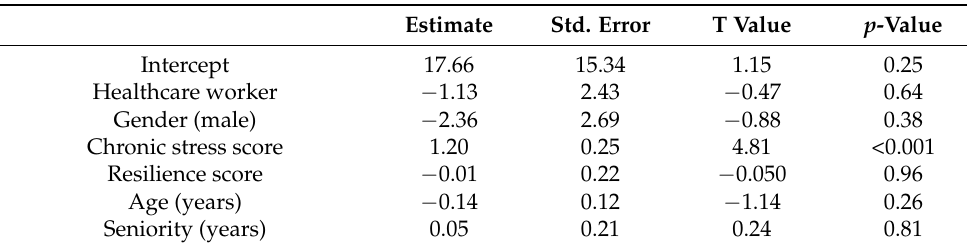
Table 3. Results of the multiple linear regression analysis of Q1 results. The dependent variable was the Q2 work-related stress score.